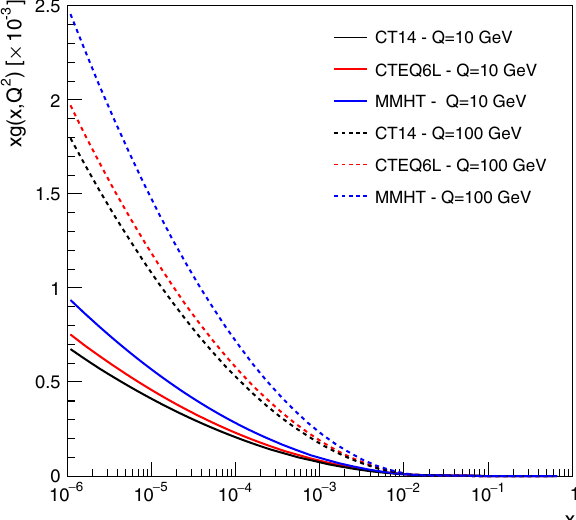
Fig. 1 Gluon distribution function, xg ( x , Q 2 ) , following from DGLAP evolution for PDFs, CT14, CTEQ6L and MMHT at Q = 10 GeV and Q = 100 GeV